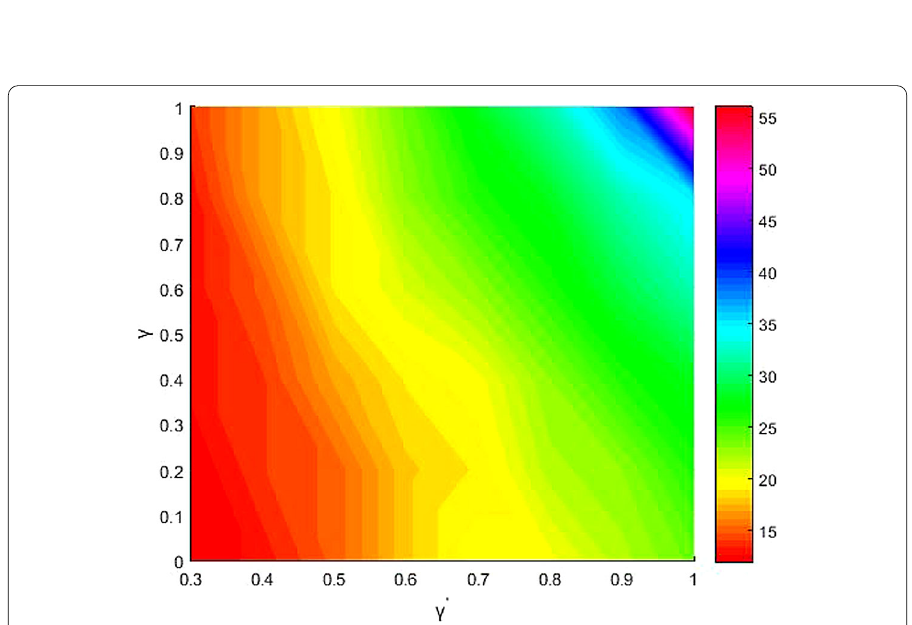
Figure 12 Performance of number of iterations with γ (cid:3) and γ